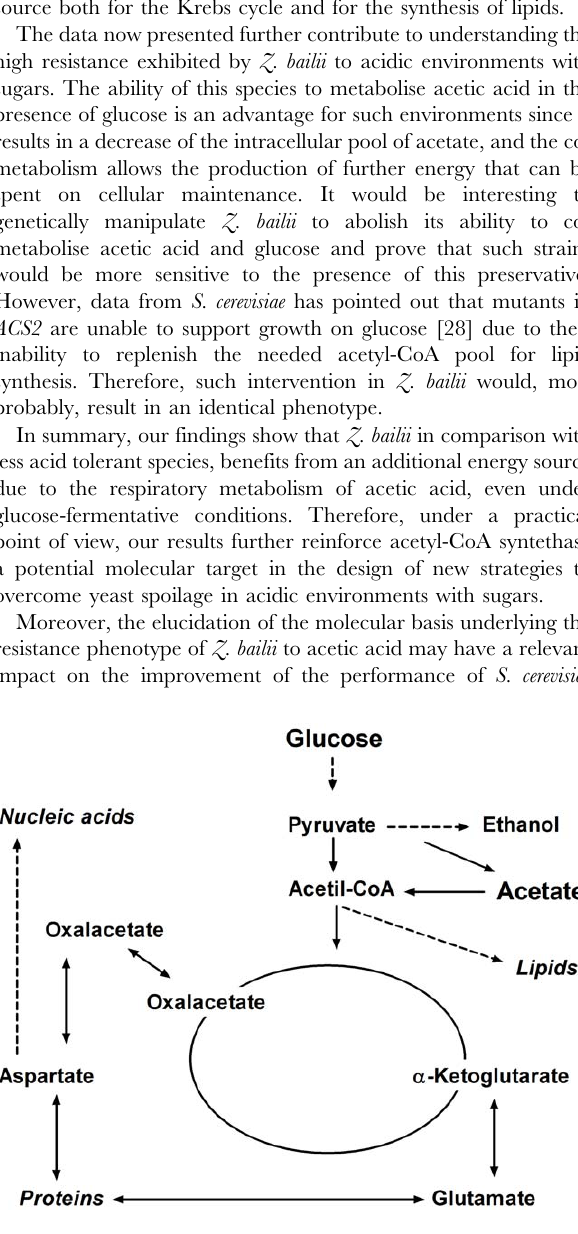
Figure 3. Major metabolic pathways involved in the simulta- neous utilisation of glucose and acetic acid in Z.bailii ISA 1307.